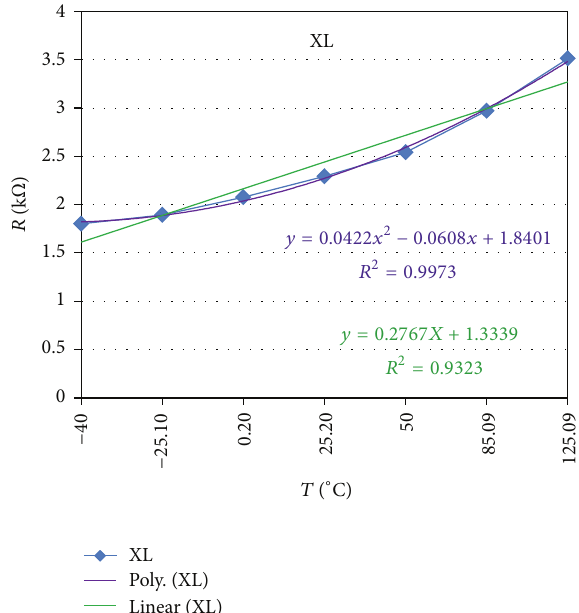
Figure 1: The measured input resistance versus temperature for XL